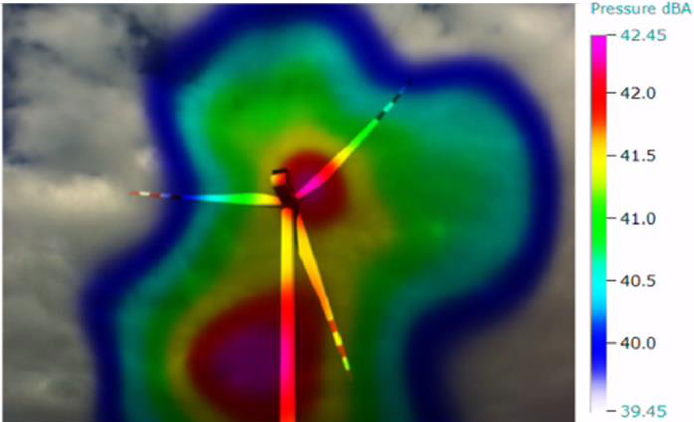
Figure 19. Acoustic photo illustrating the location of the occurrence of acoustic wave during operation of wind turbine [7].